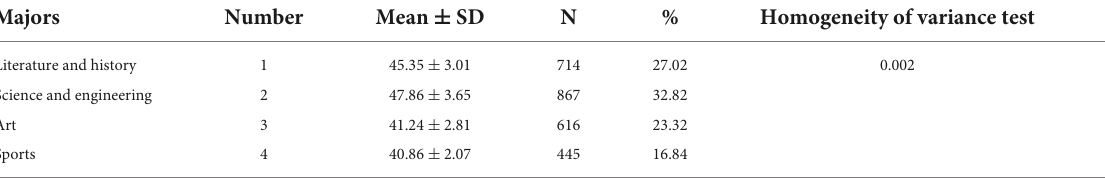
TABLE 5 Comparison of GSI T-score among different majors. Majors